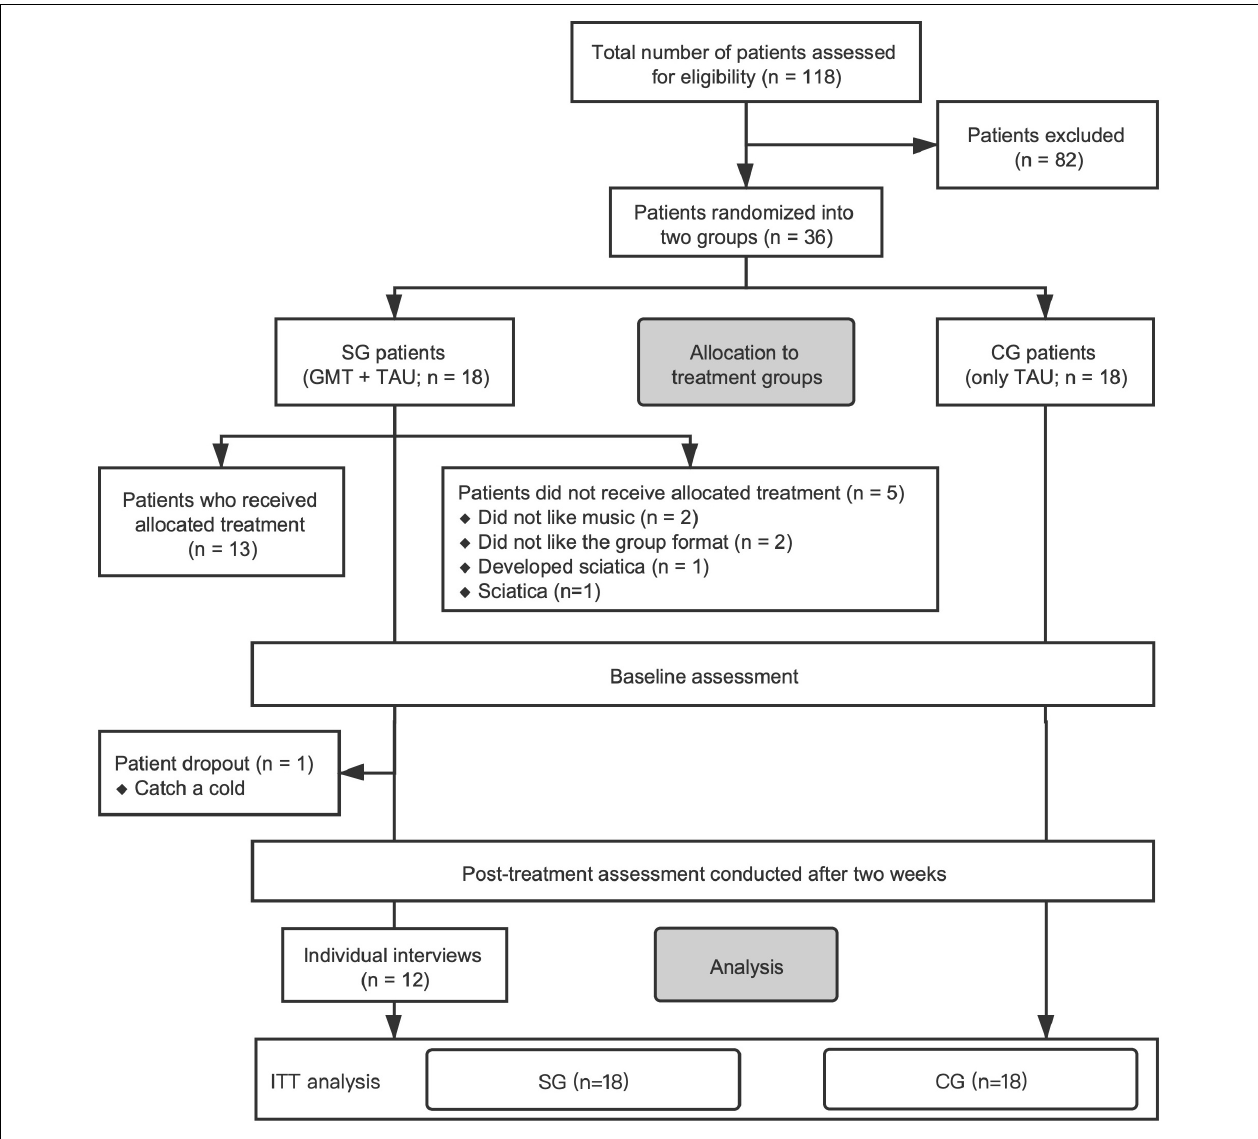
FIGURE 1 | Consolidated Standards of Reporting Trials (CONSORT) participant flowchart depicting the patient selection process. SG, study group; CG, control group; GMT, group music therapy; TAU, treatment-as-usual; ITT, intention-to-treat